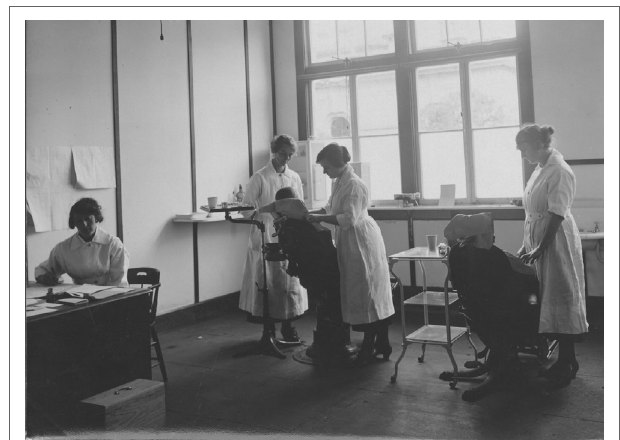
FiguRe 3 | The extraction room, Training School, Wellington, 1922 [Archives New Zealand/Te Rua Mahara o te Kawanatanga, Wellington Office (Archives Reference: ABKI 667/1)]. Dental nurse trainees treated Wellington school children, with their oral health need being so great that an “extraction room” was set up. Two students each day would be assigned to the room and would spend the day extracting